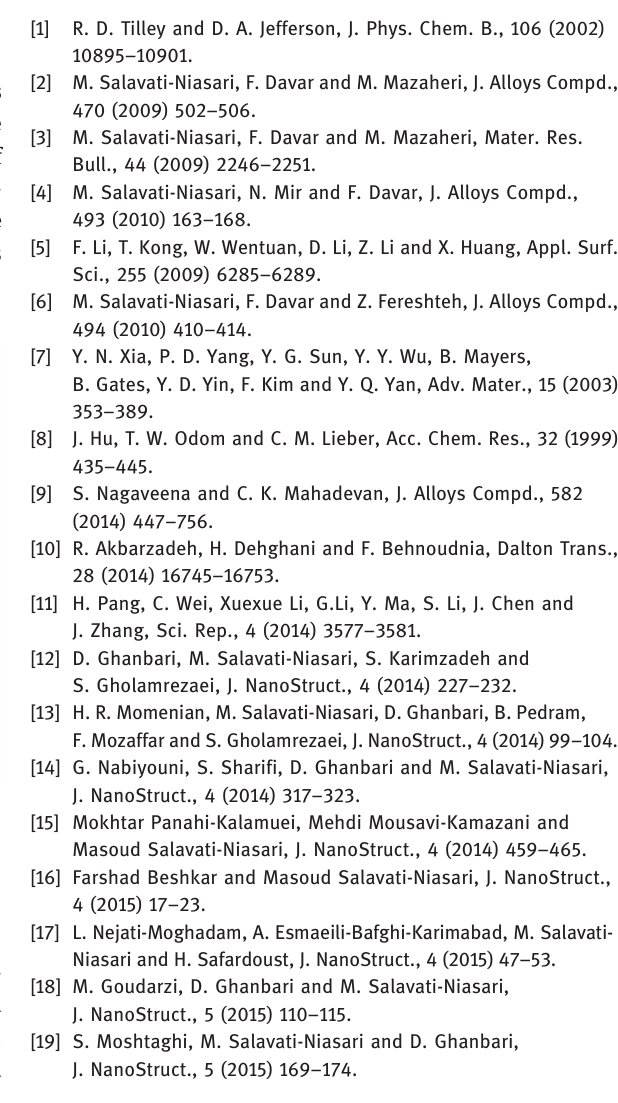
Figure 3: FT-IR spectra of NiS 2 nanoparticles.